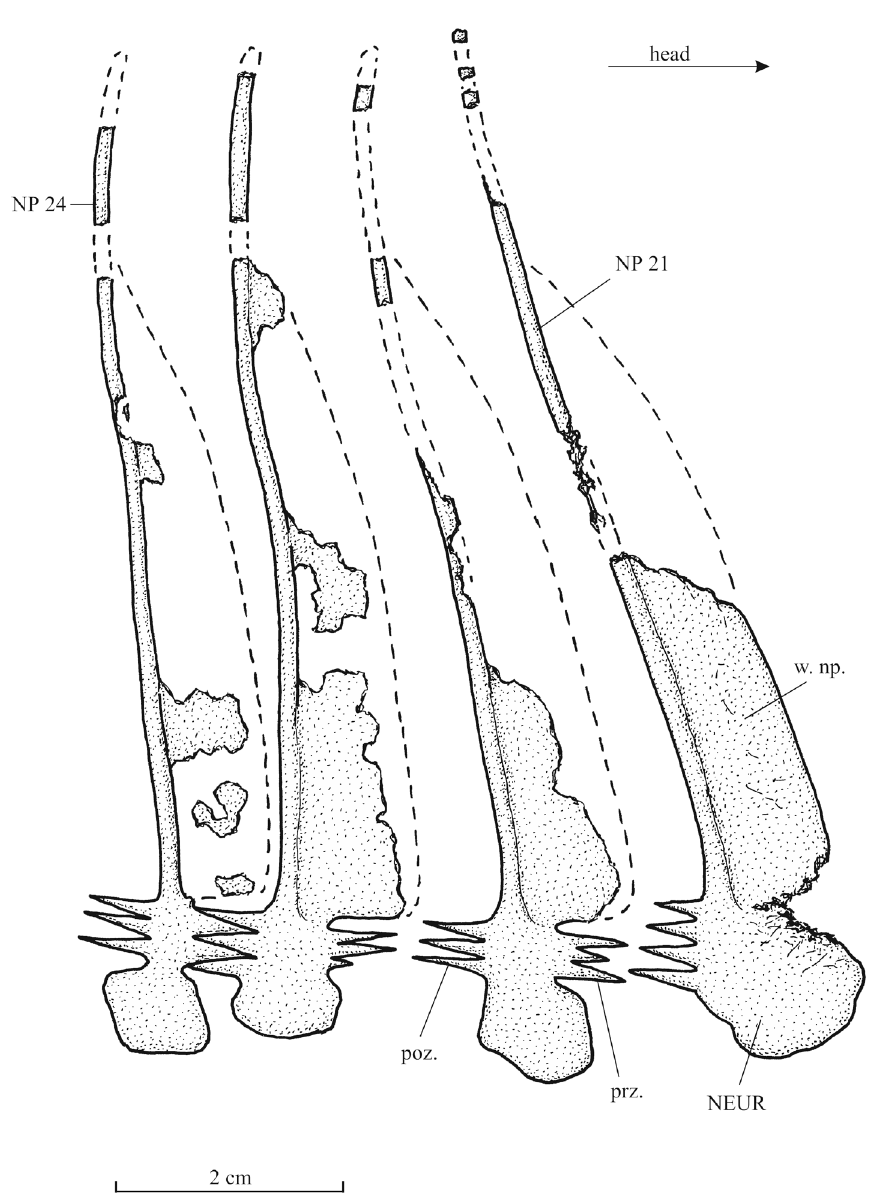
Fig. 20. Sigmapycnodus giganteus gen. et sp. nov., holotype, neural arches and spines 21–24 (CLC S-497b), showing the hypercomplex contact between the